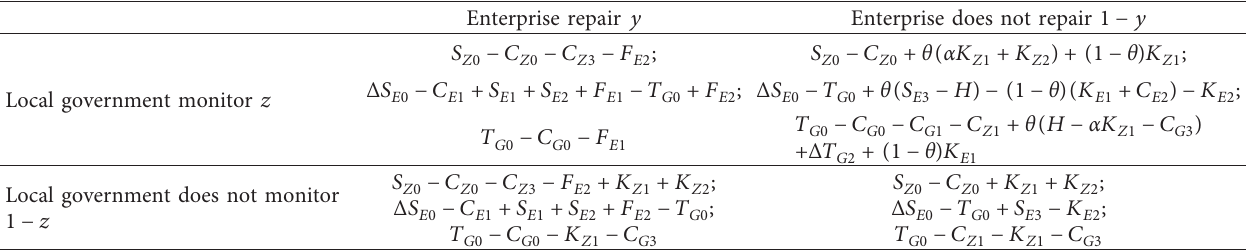
Table 1: Tripartite game strategy combinations under the supervision ( x ) of the central government. Enterprise repair y